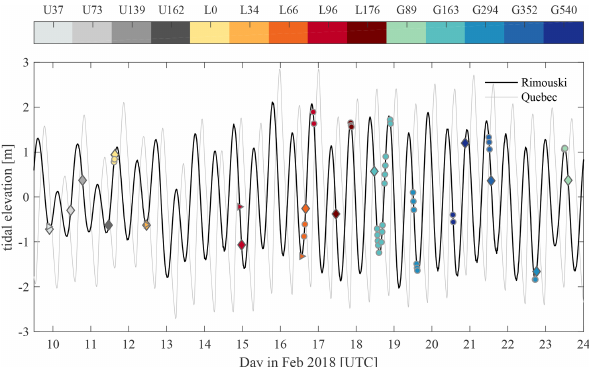
Figure 2. Observed tidal amplitudes at Rimouski (station no. 2985) and Quebec City (station no. 3248) maintained by Fisheries and Oceans Canada. The circles and diamonds respectively denote when the VMP and CTD rosette profiled at each station, designated by the color bar. The smaller triangle denotes the SBE 19 CTD, which provided near-surface measurements when the rosette was deployed from the moon pool. Tidal levels near station G163 (Grande-Vallée) precede those at Rimouski by about 15min, while those recorded at Tadoussac (station L0) lag Rimouski by another